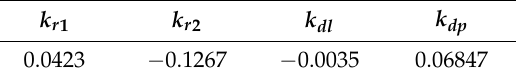
Table 2. k r 1 , k r 2 , k dl and k dp for scenario